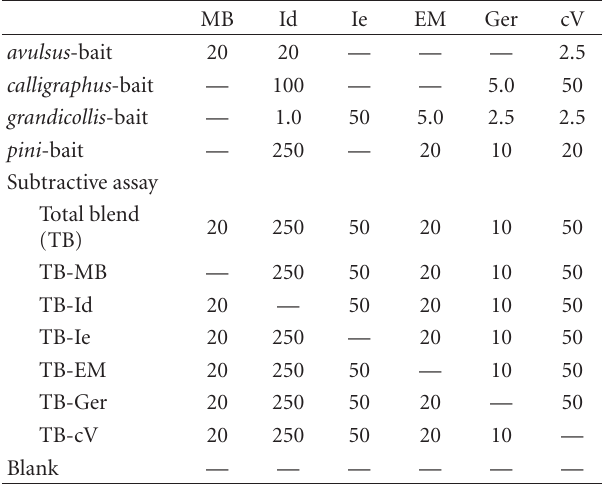
Table 2: Pilot study, Francis Marion National Forest, SC, and Nan- tahala National Forest, NC, July 1990: pheromone candidates released from Wick-baits: for abbreviations, see Table 1. Release rates are given in μ